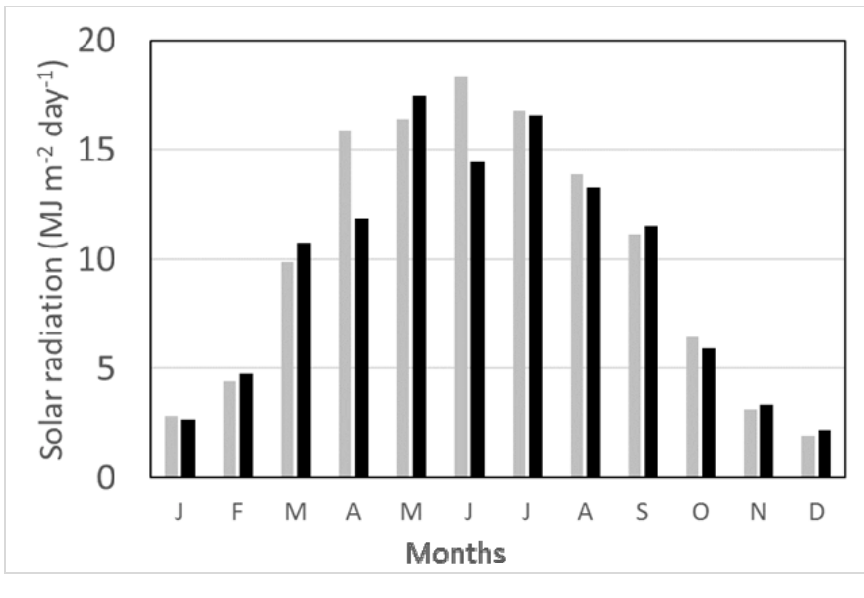
Figure 2. Solar radiation (MJ m − 2 day − 1 ) measured in 2011 ( ) and 2012 ( ).